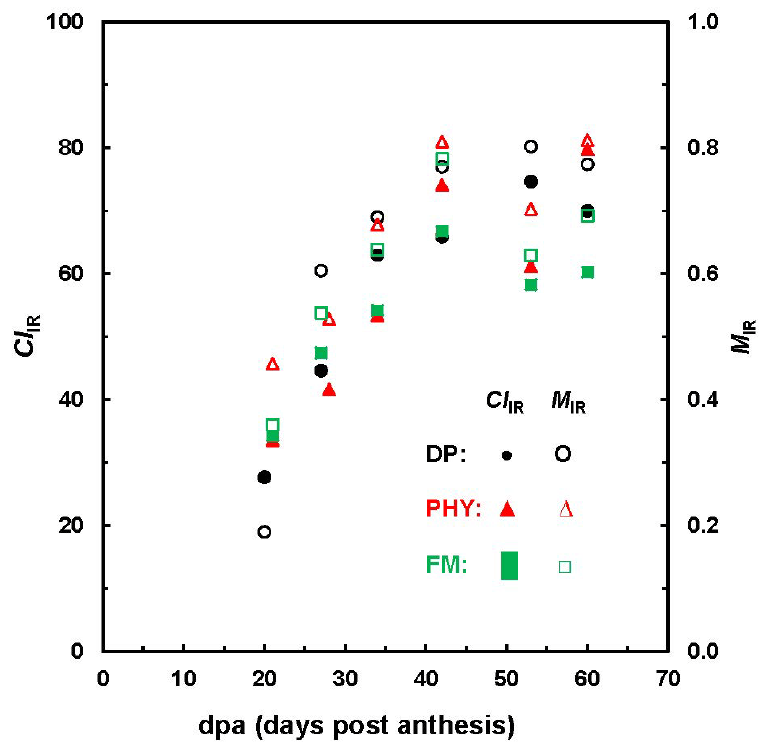
and CI values against fiber IR IR